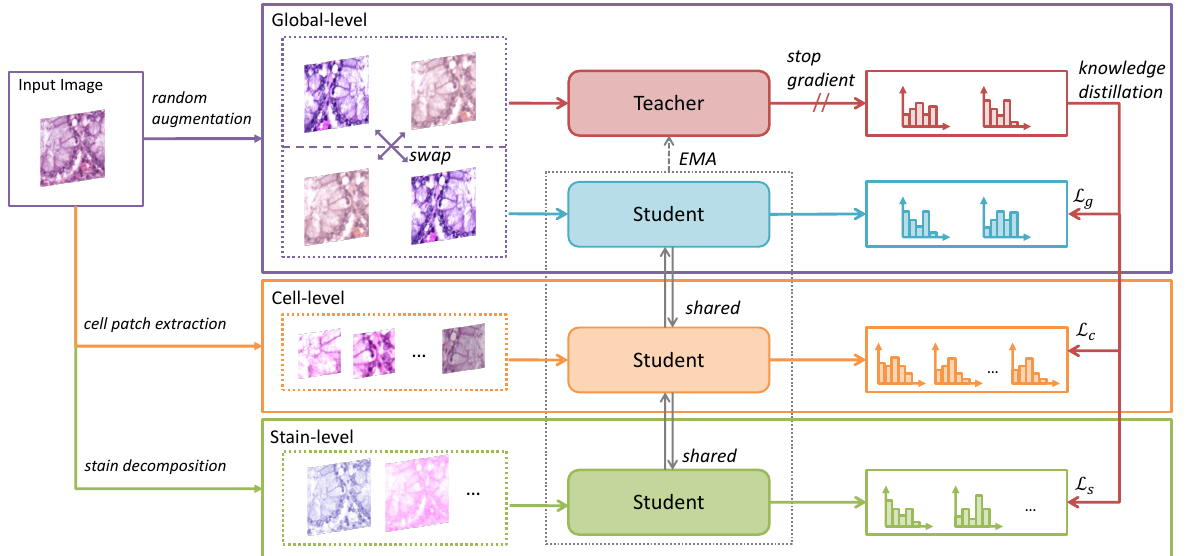
Figure 1. Illustration of our proposed framework, HistoSSL. HistoSSL learns representations from the feature correspondence by performing knowledge distillation. The student model is trained by aligning the student’s output distribution with the teacher’s distribution. Knowledge distillation is performed at three levels: global-, cell-, and stain-level. Global-level views are generated via random augmentations, cell-level views are generated by extracting cell-level patches, and stain-level views are generated from stain decomposition. The parameters of the teacher network are an exponential momentum average (EMA) of the